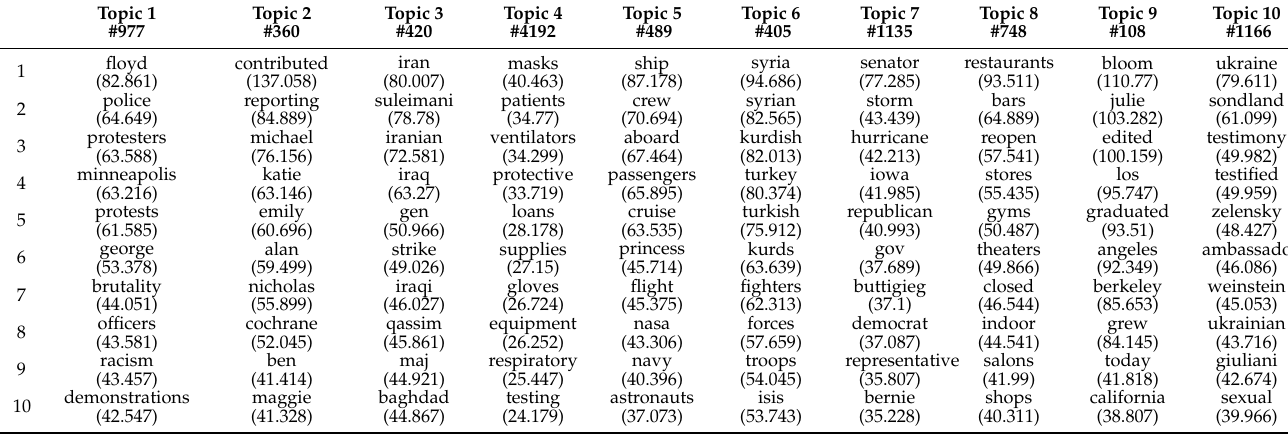
Table A21. Each column lists the top 10 representative words per dimension of the basis matrix A .